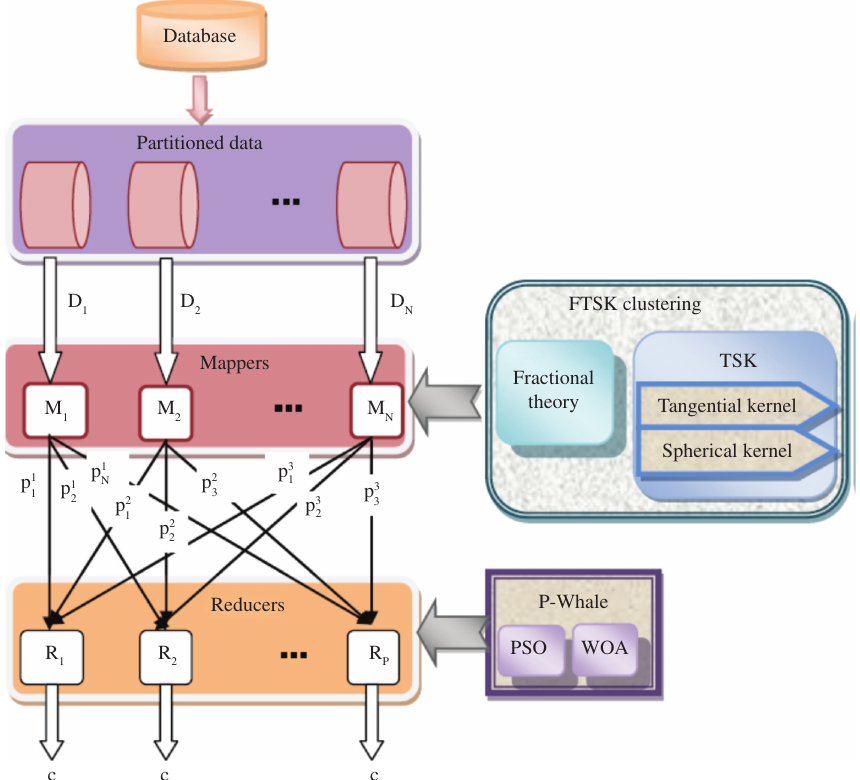
Figure 1: Block Diagram of the Proposed